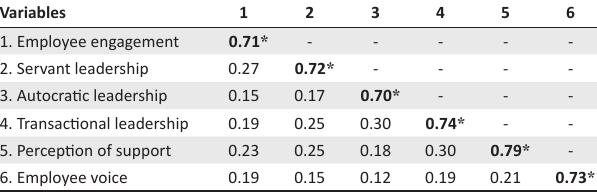
TABLE 3: Discriminant